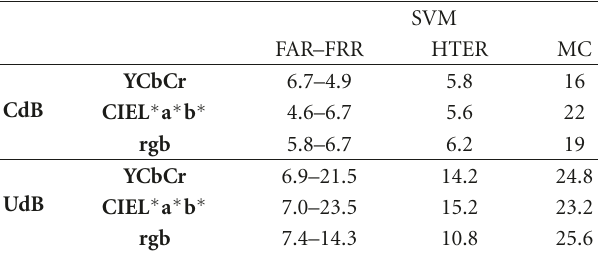
Table 6: HTER values at EER for two-class SVM and 3D color